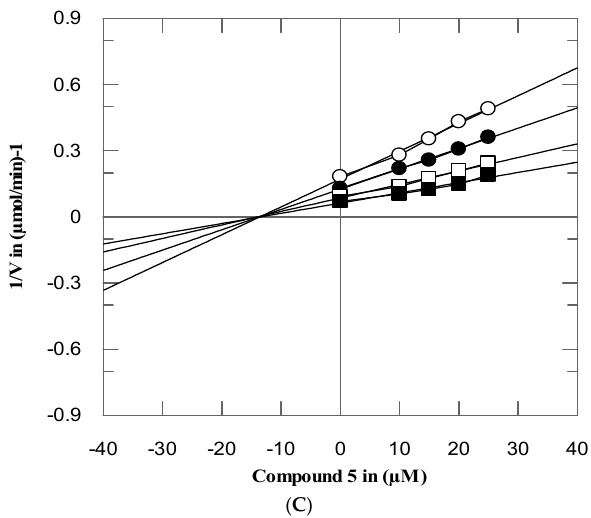
Figure 5. The inhibition of α -glucosidase by compound 5 ( A ) Lineweaver–Burk plot of reciprocal of rate of reaction (velocities) vs. reciprocal of substrate ( p -nitrophenyl- α -D-glucopyranoside) in the absence ( ▲ ), and in presence of 10 ( ∆ ), 15 ( ■ ), 20 ( □ ), 20 ( ● ), and 25 μ M ( ○ ) of compound 5 . ( B ) Secondary replot of Lineweaver–Burk plot between the slopes of each line on Lineweaver–Burk plot vs. different concentrations of compound 5 . ( C ) Dixon plot of reciprocal of rate of reaction (velocities) vs. different concentrations of compound 5 .